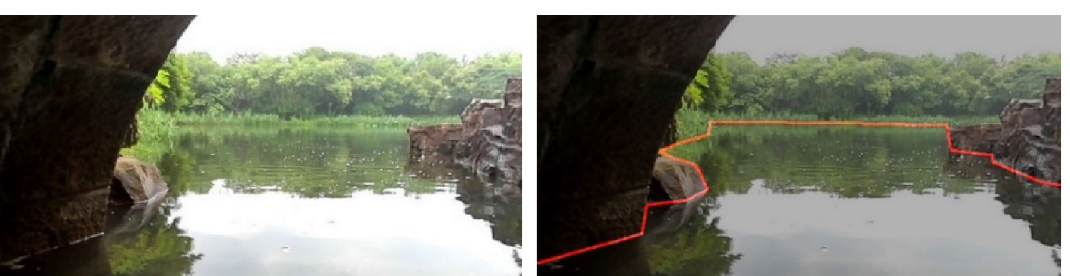
Fig. 8 Improved pyramid pool module